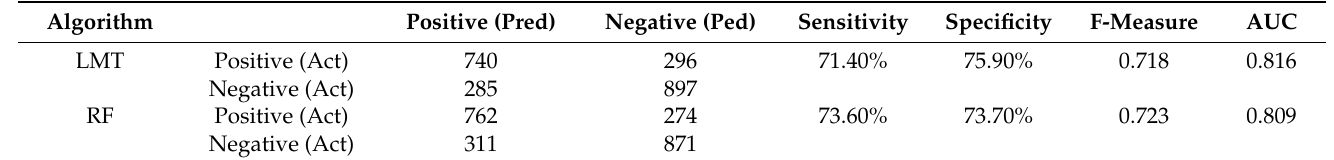
Table 3. Demonstration of two machine learning algorithm results.